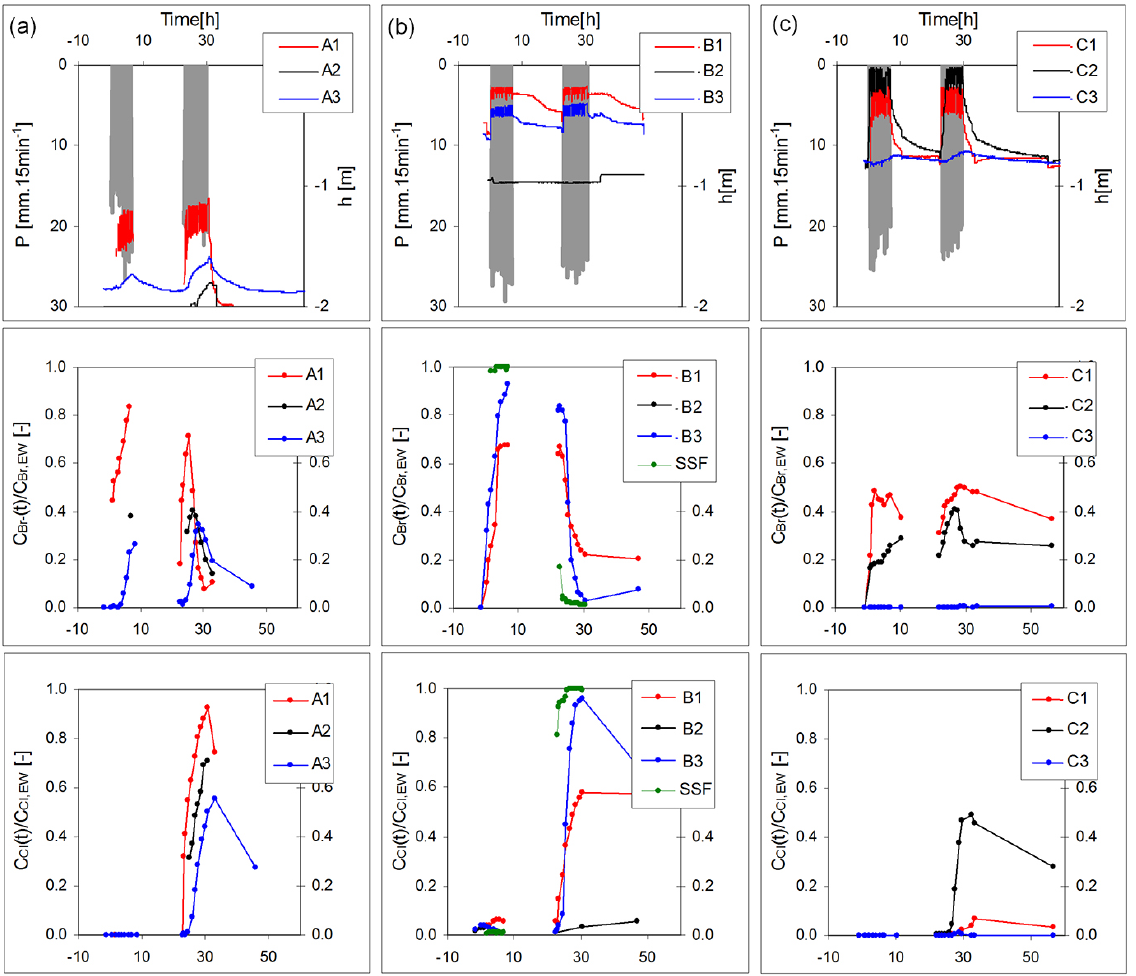
Figure 2. Monitoring results of three sprinkling experiments: (a) plot A, (b) plot B and (c) plot C. Upper panels show the intensity of the sprinkling (primary y axis) and groundwater responses in piezometers (secondary y axis). Middle and bottom panels show the ratio between tracer concentration measured in the piezometers or subsurface runo ff (SSF) and the applied tracer concentration.